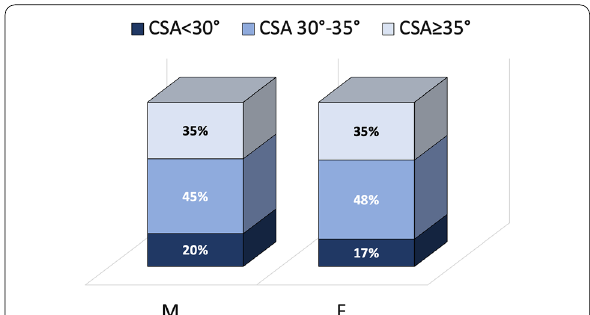
Fig. 4 Distribution of CSA in males and females according to the three subcategories of CSA values (< 30°; 30–35°;